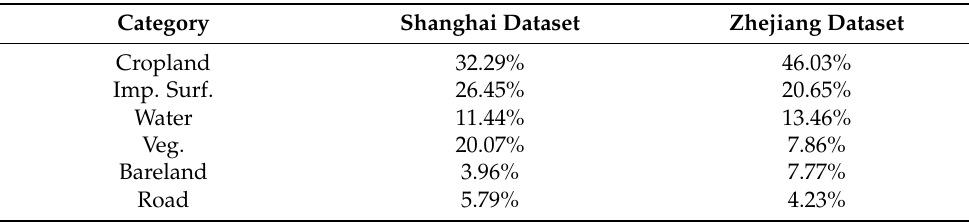
Table 1. Pixel statistics among categories for Shanghai and Zhejiang datasets.